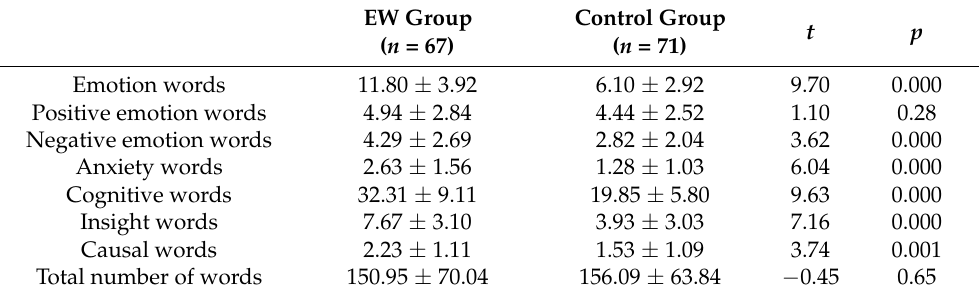
Table 1. Analysis of the written content of the EW group and the control group (M ± SD).